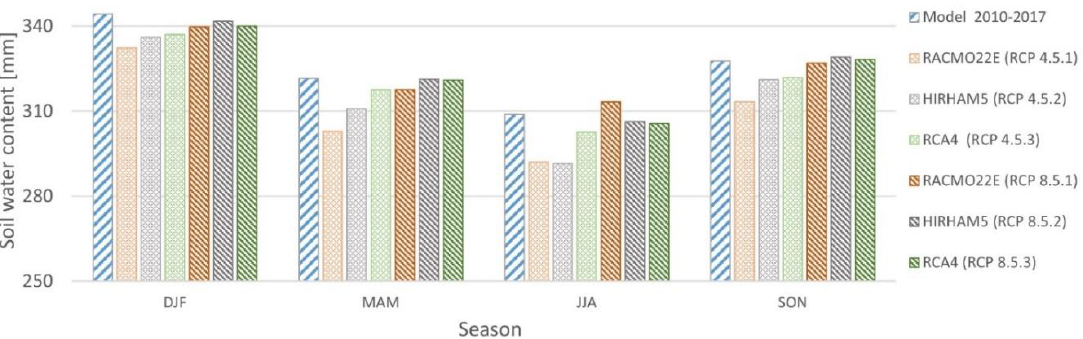
Figure 2. Seasonal average soil water content (1.5 m) for 2041–2050 and for the SWAT 2010–2017 model for individual climate projections RCP 4.5.1, RCP 4.5.2, RCP 4.5.3, RCP 8.5.1, RCP 8.5.2, RCP 8.5.3 (own study).